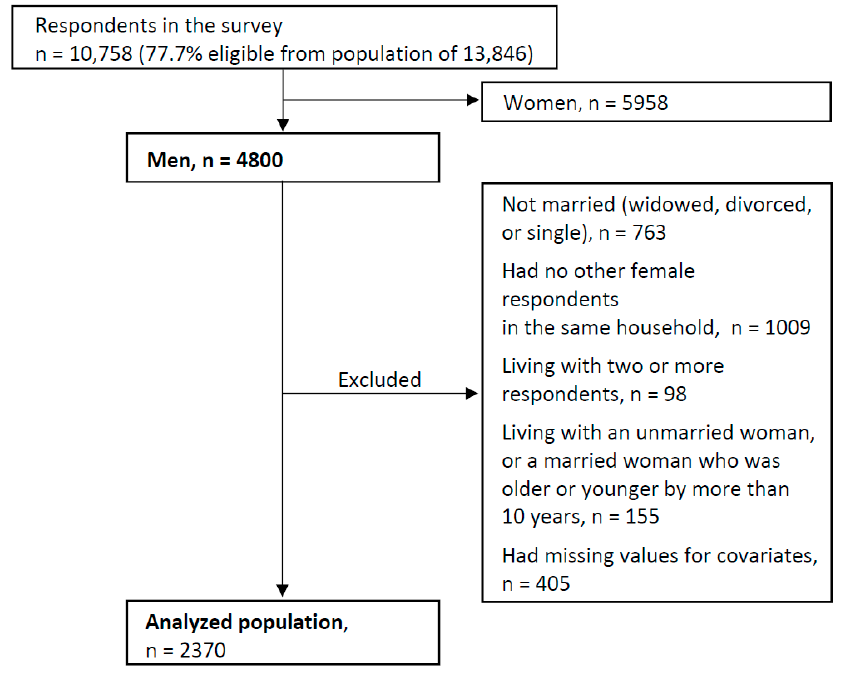
Figure 1. Study population.